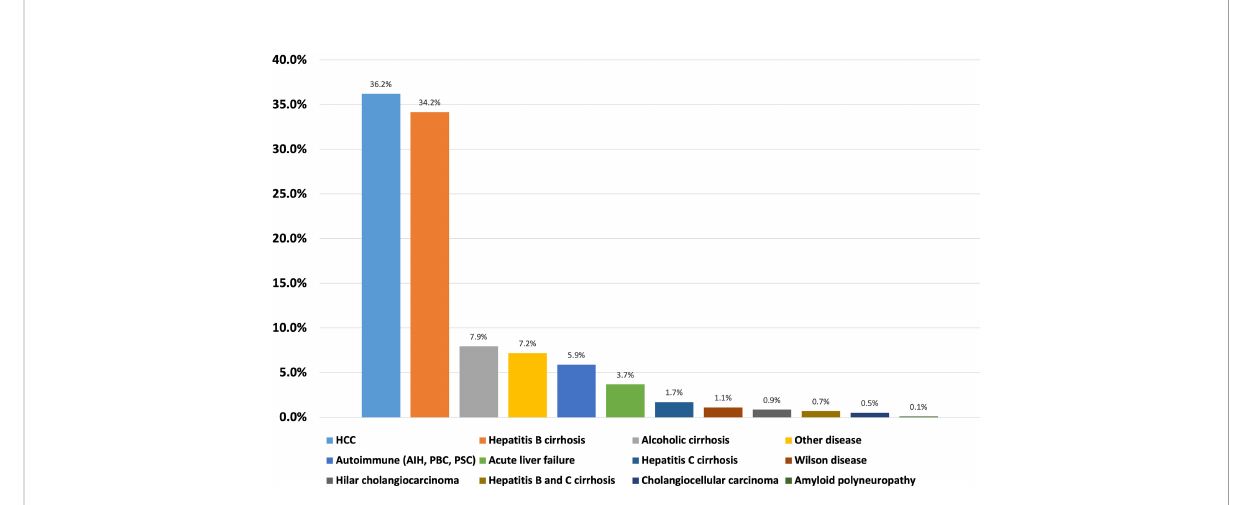
FIGURE 3 Biliary complications ratios after liver